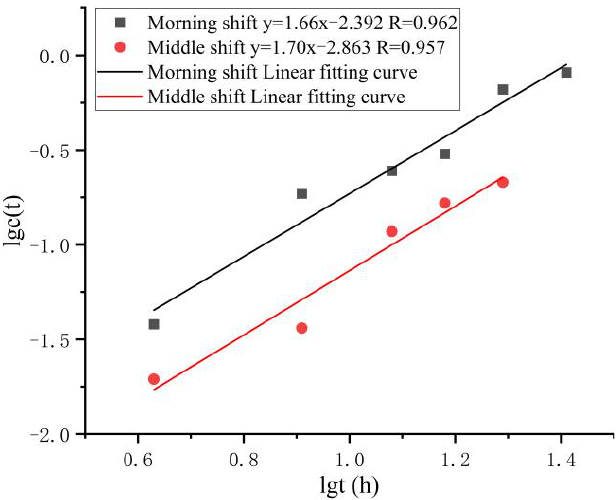
Figure 4. Daily hourly fractal fit of microseismic events.